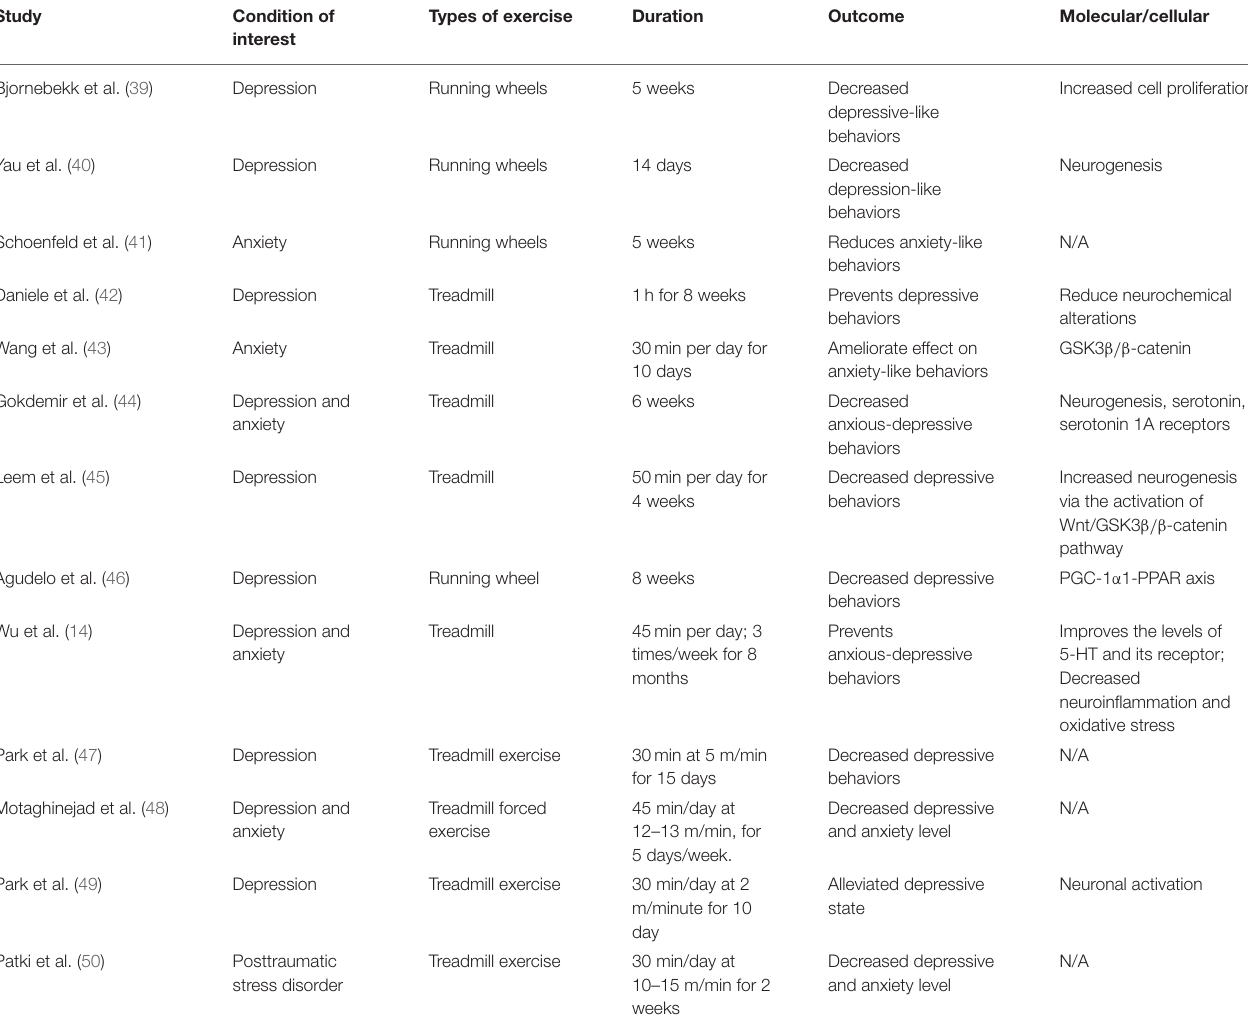
TABLE 1 | Summary of the effect of exercise on anxiety and depression in animal